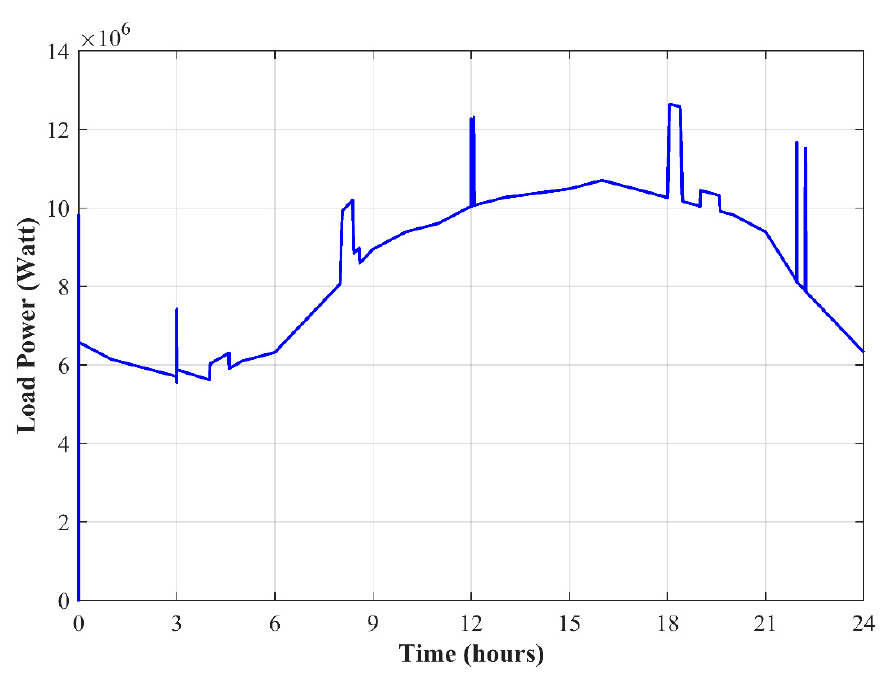
Figure 6. Wind speed profile.